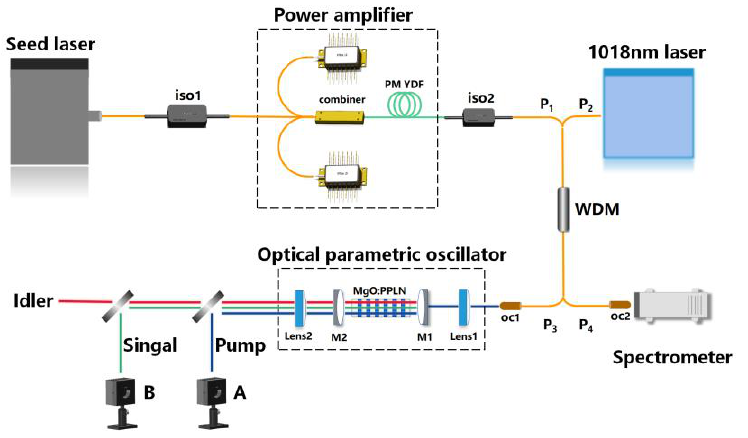
Figure 1. Schematic diagram of broadband OPO intracavity difference frequency